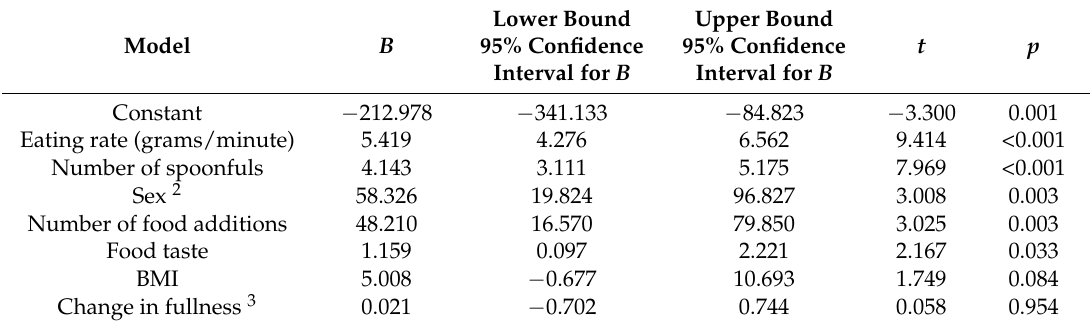
Table 2. Multiple linear regression model 1 explaining variations in food intake.